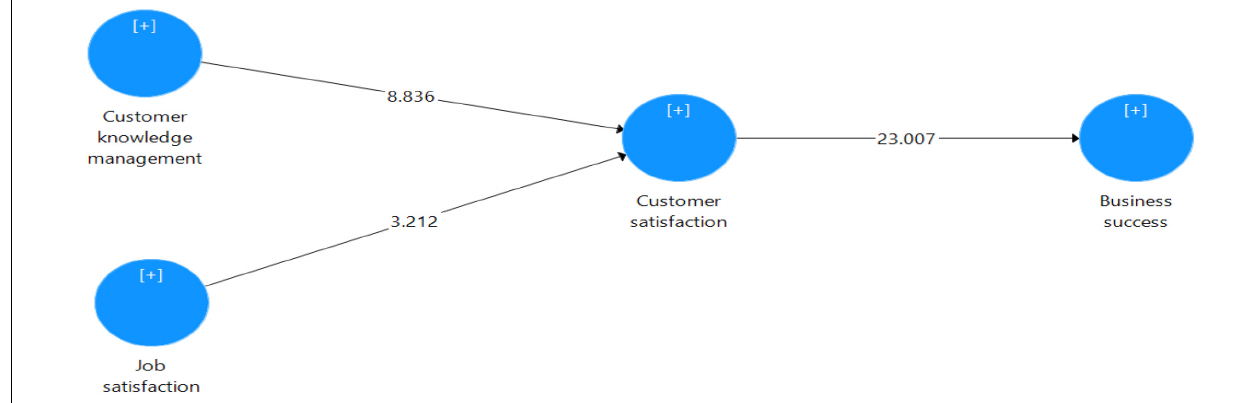
FIGURE 1 | Exhibits the bootstrapping model. Source, Author’s